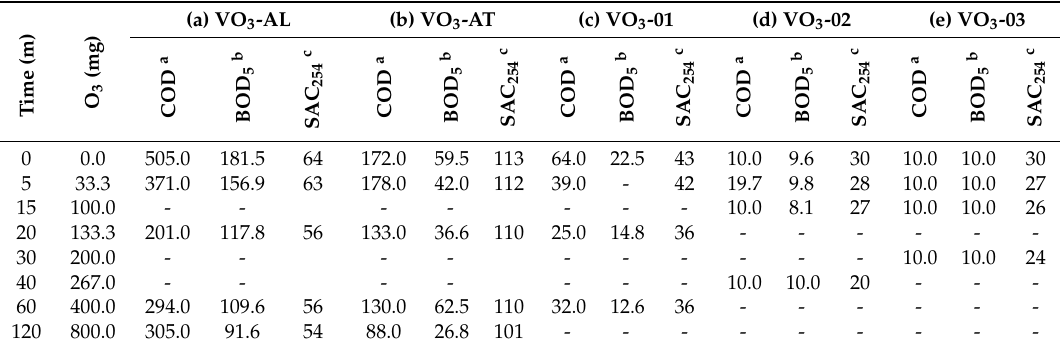
Table 3. Chemical Oxygen Demand (COD) and Biochemical Oxygen Demand (BOD 5 ) concentration values during treatment with O